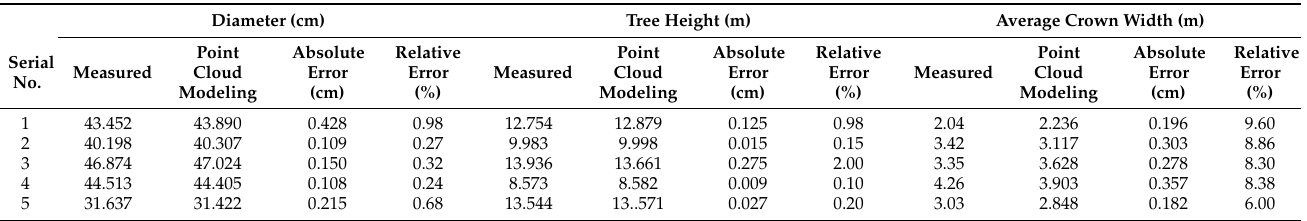
Table 5. Calculation results of single tree height, diameter at breast height, and crown width.